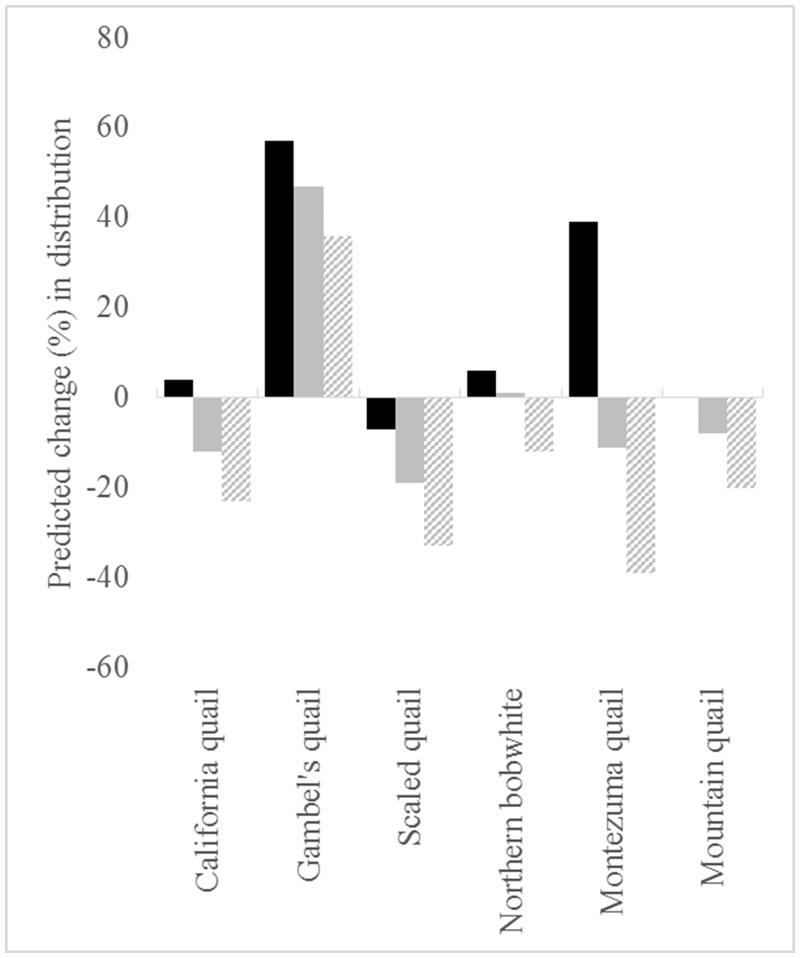
Estimated percentages of distribution shifts for temperate North American quail based on ensemble projections of Maxent models into 2070.Ensemble forecast model agreement is indicated as followed: 75% (black), 90% (gray), and 100% (striped).